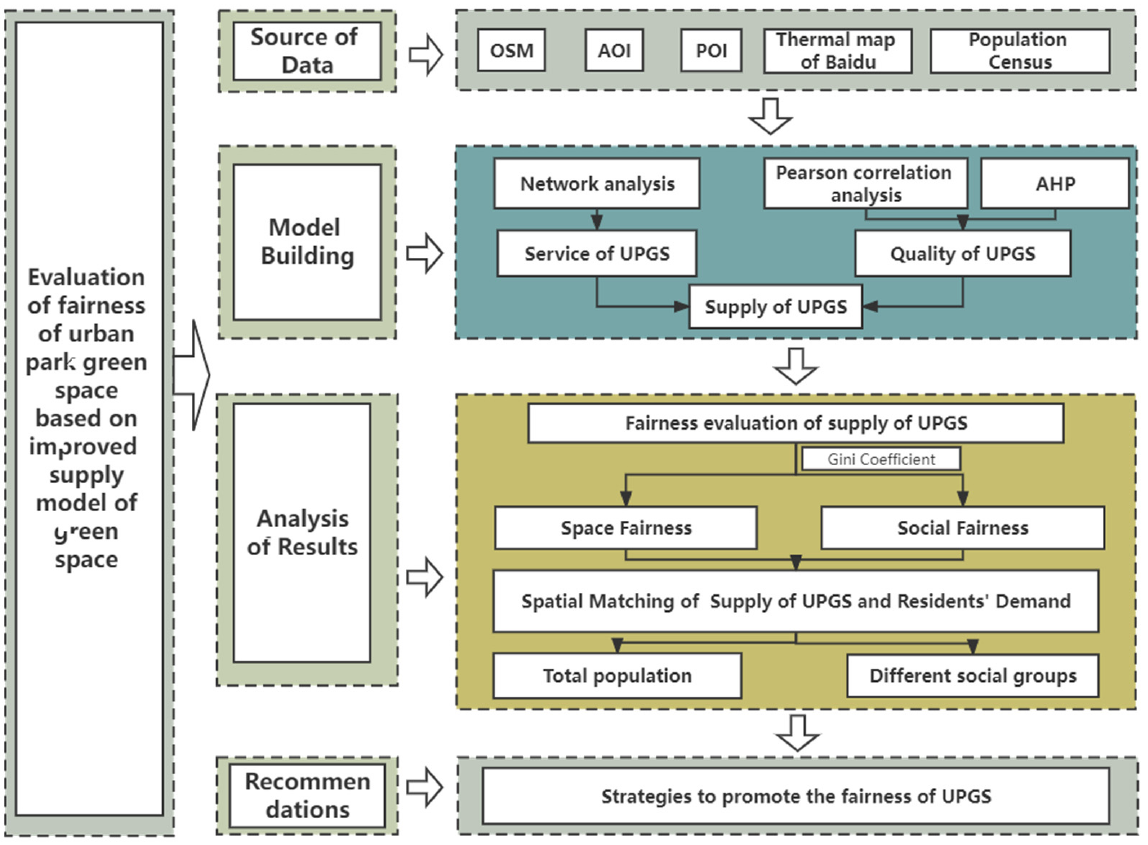
Figure 1. Technical route.